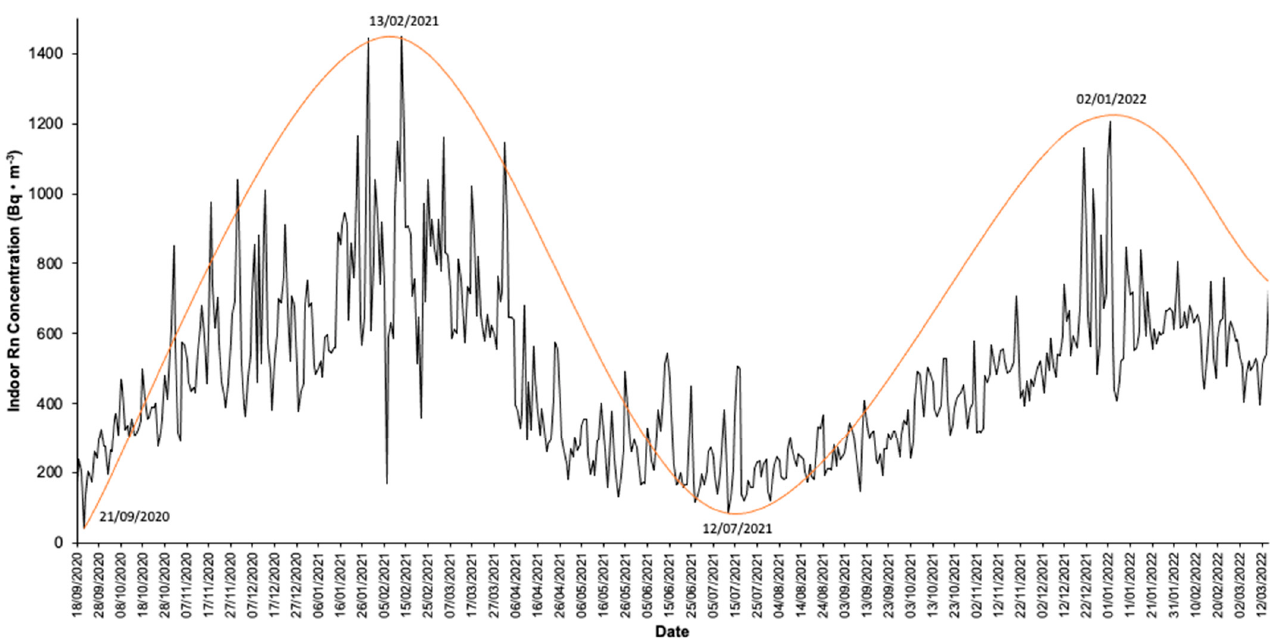
Figure 2. Evolution of the indoor Rn concentration over the period under review. The black line represents the indoor Rn concentration, and the orange line represents the oscillation over time, determined using the recorded peaks (maximum and minimum) and the respective occurrence dates.